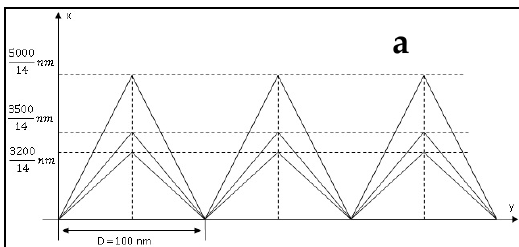
Figure 3. ( a ) Selective periodic texturing with three aspect ratios (64/14, 70/14 and 100/14) for simu- lation, ( b ) surface spectral reflectance for three triangular microstructures of interest with a base of 14 nm and the aspect ratio of 64/14, 70/14 and 100/14. Note that the green curve addresses a reflec- tance of less than 10%.